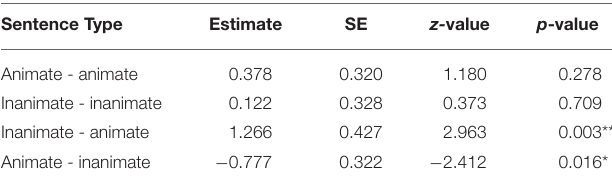
TABLE 3 | Child verbal response results: Pairwise contrasts, comparing No Face and Face conditions for each sentence type. Sentence Type